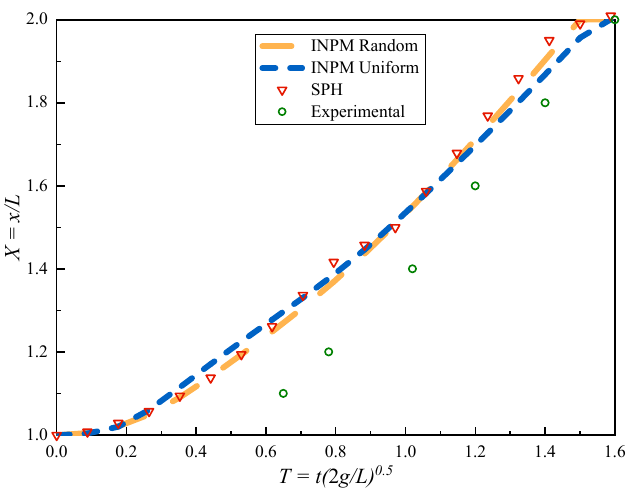
Figure 4. Comparison of experimental data and numerical simulation of the water front tip with different particle